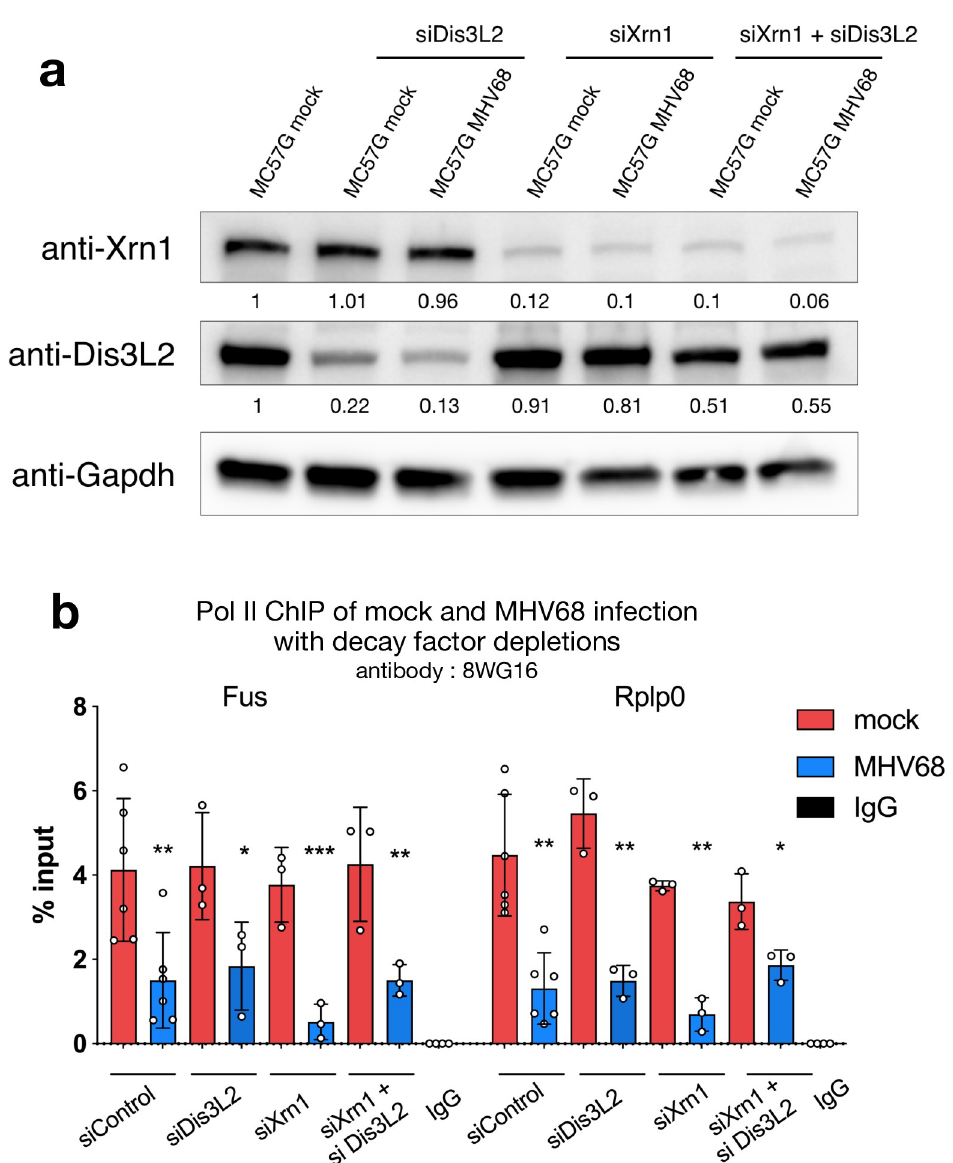
Fig 2. Knockdown of host RNA decay factors does not rescue Pol II occupancy. (A) Representative western blot showing the efficiency of Dis3L2 and Xrn1 knockdown (kd) in MC57G cells, with Gapdh serving as a loading control. Densitometry of band intensity normalized to Gapdh and MC57G mock infection are indicated below blots. (B) ChIP- qPCR of Pol II occupancy at the Rplp0 and Fus promoters with standard deviation. Pol II ChIP was performed on mock and MHV68 WT infected MC57G cells treated with the indicated siRNAs. IgG is from the siControl MHV68 infection condition. ( � p < 0.05, �� p < 0.001, ��� p < 0.0001 students paired t-test on raw % input